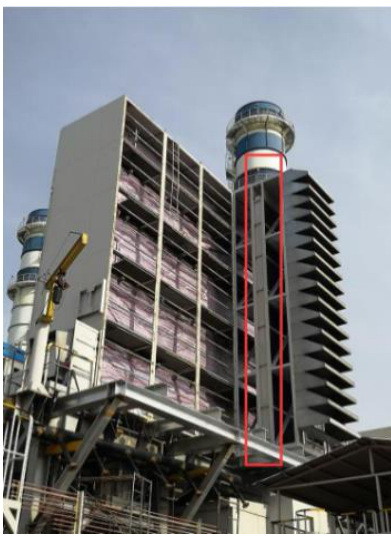
Figure 3. Inlet air heating system applied in the gas turbine power plant in Tianjin, China.